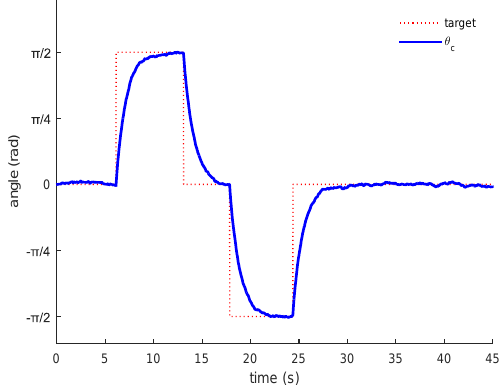
Figure 13. The orientation of the